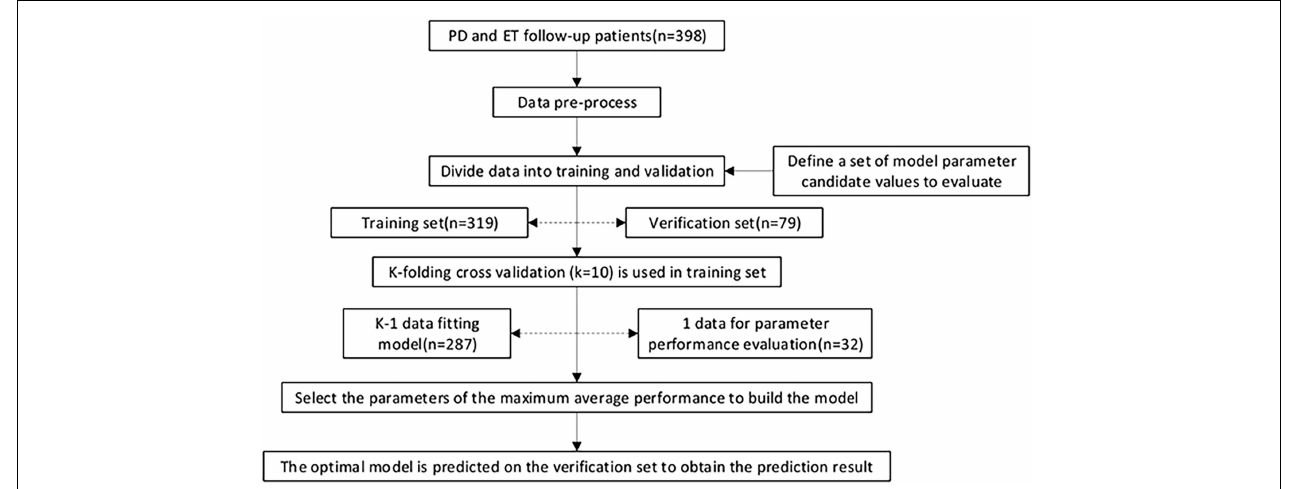
FIGURE 3 | Model training, parameter adjustment, and performance evaluation. 398 patients were recruited in the current study. The data were pre-processed and randomly divided into a training set (80%) and a validation set (20%), and the proportion of the two class proportions in each set is the same. In the training set, k-fold cross-validation ( k = 10) is used, and various parameter combinations are exhausted by grid search. Performance evaluation index of AUC was adopted to judge the average predictive performance of the model. The average performance maximum is used as the best performance tuning parameter, and the prediction is finally performed on the test set.